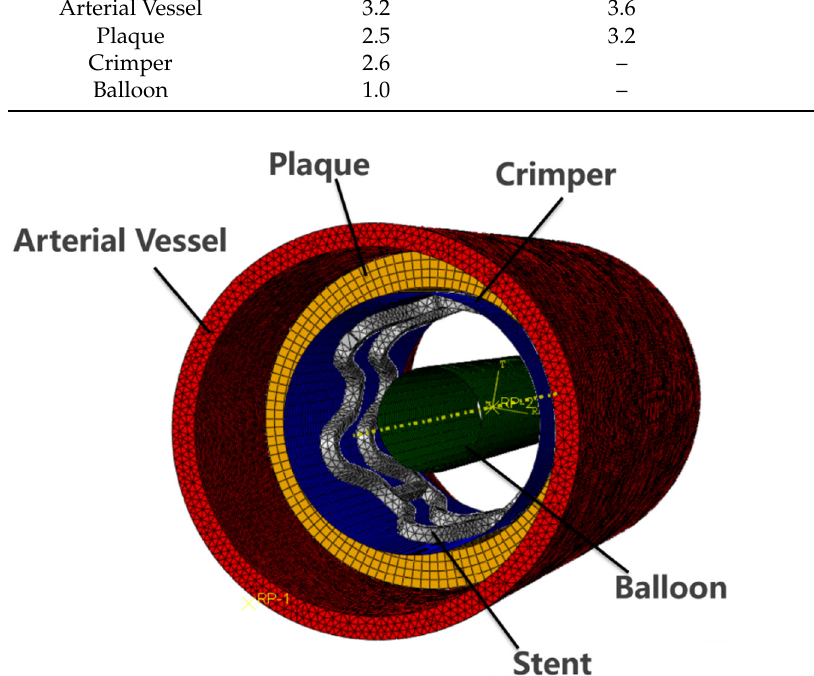
Figure 3. The mesh of L-type coronary artery stent coupling system.